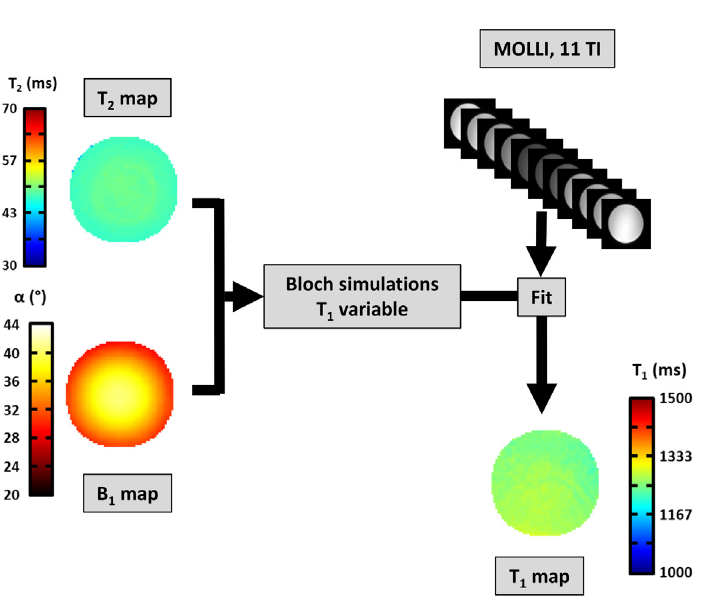
Fig 1. Description of the novel post-processing approach of the MOLLI sequence to derive T1 maps on a 2.2L agar phantom. Simulated datasets were adjusted pixel by pixel on experimental data points obtained using the MOLLI sequence by varying T1 and using T2 and B1+ parameters measured with separate specific MR